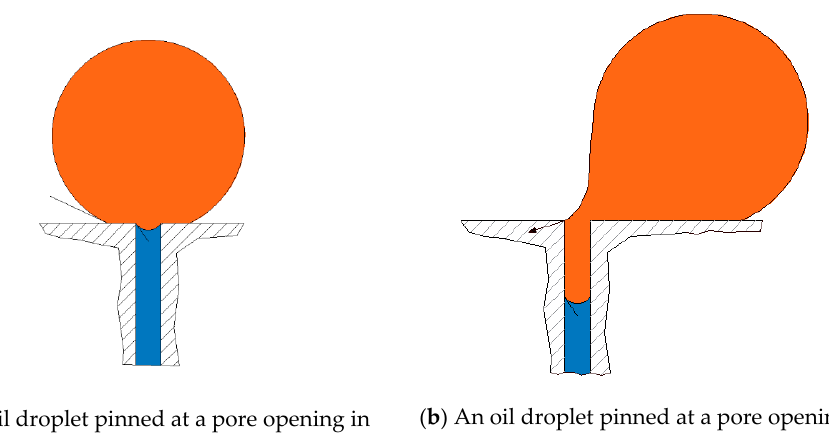
Figure 3. When an oil droplet is pinned over a pore opening, it can assume a symmetrical profile ( a ), as is the case for pressure-driven filtration, or a deformed profile ( b ), as in the case for crossflow filtration, with the degree of deformation being dependent on the crossflow velocity.